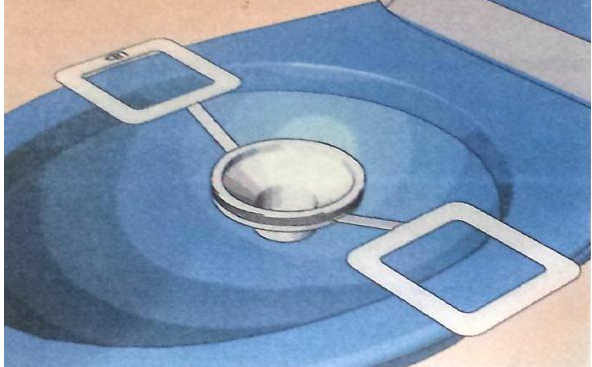
Figura 14. Encaixe e posicione o suporte na borda do vaso sanitário.